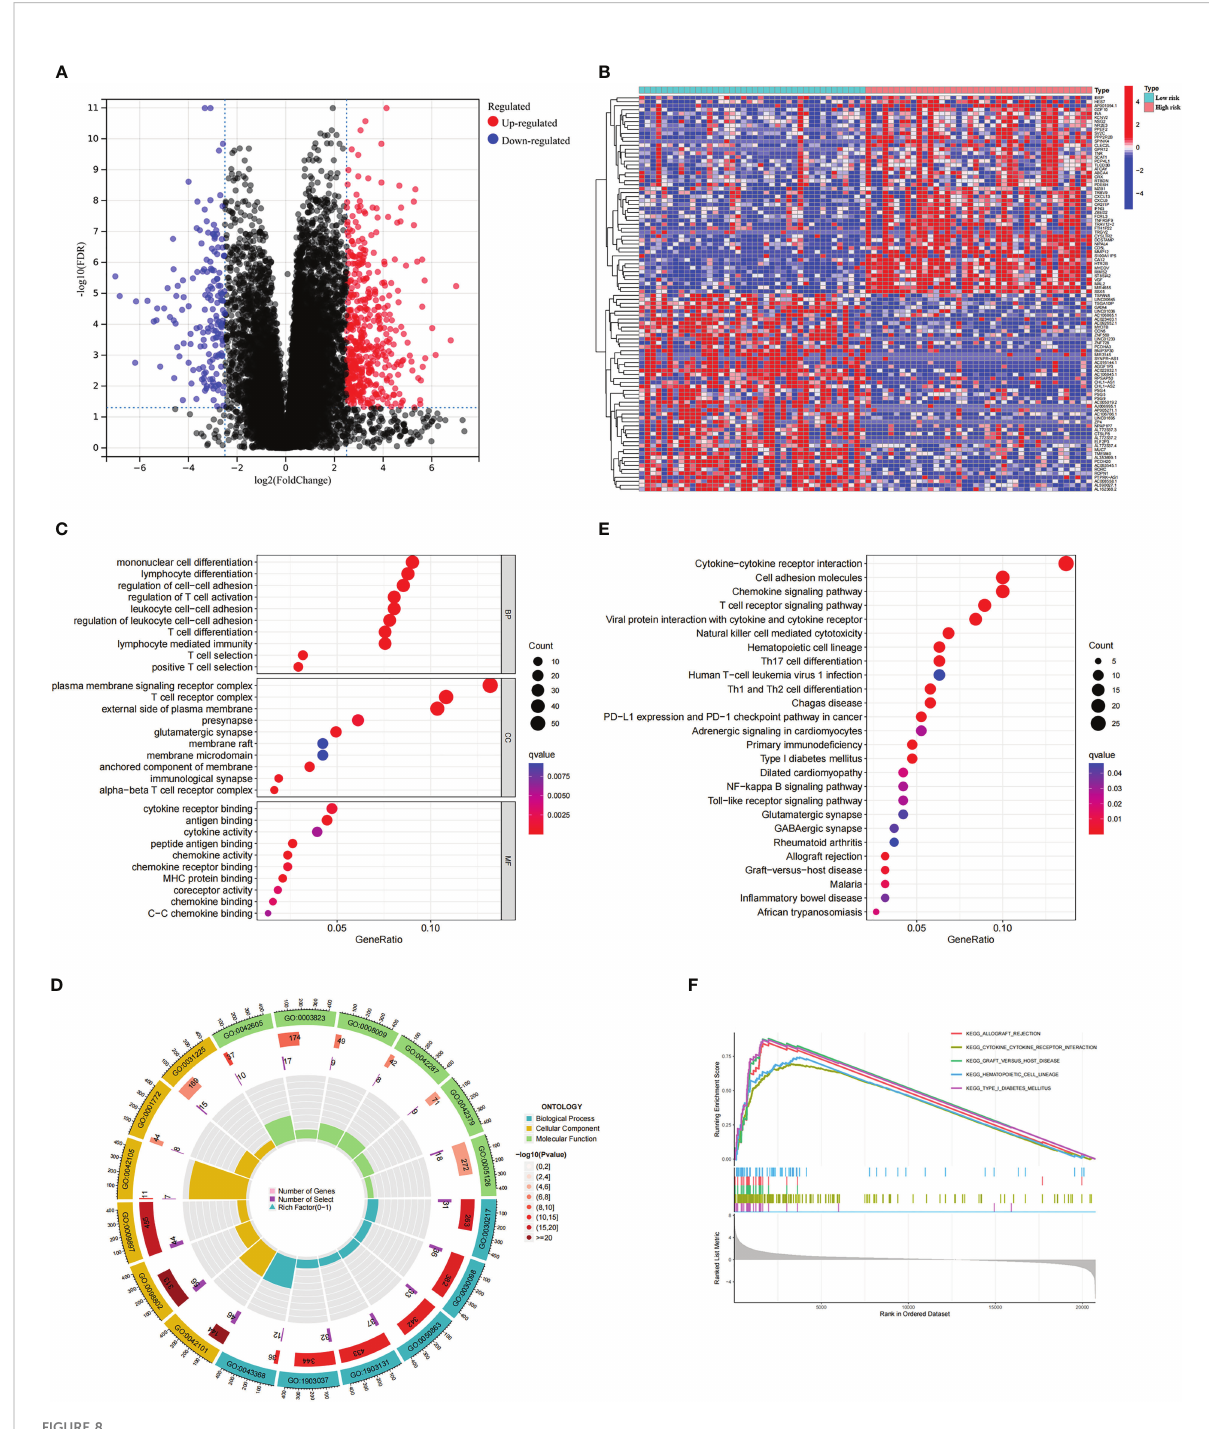
FIGURE 8 Analysis of the DEGs and functional enrichment analysis in different ICD risk scores. (A) Volcano plot displays the DEGs between the high and low ICD risk groups in the TCGA cohort. (B) Heatmap of the DEGs expression between the high and low ICD risk groups. (C-E) The GO (C, D) and KEGG (E) signaling pathway enrichment analysis. (F) GSEA analysis shows the underlying signal pathway between the high ICD risk